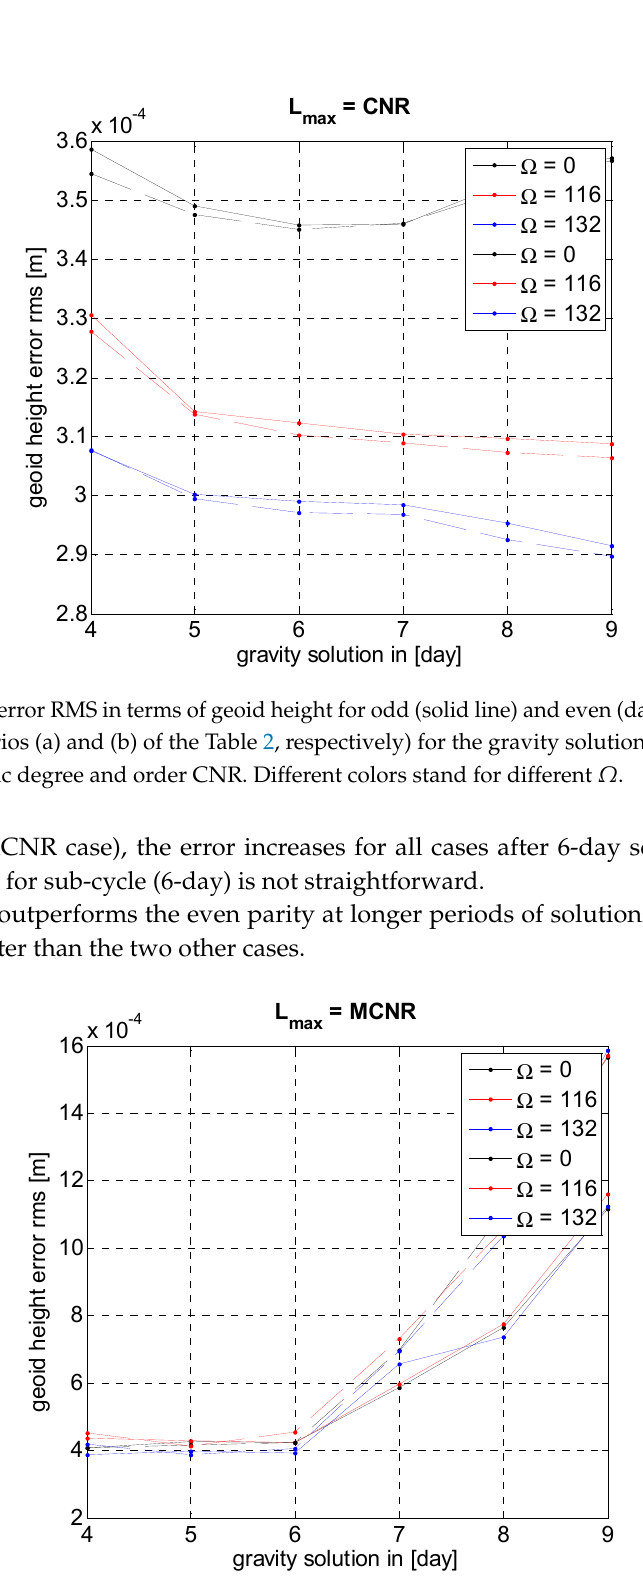
Figure 15. Global error RMS in terms of geoid height for odd (solid line) and even (dashed line) parities (Pendulum scenarios (a) and (b) of the Table 2, respectively) for the gravity solutions up to maximum spherical harmonic degree and order MCNR. Different colors stand for different Ω .